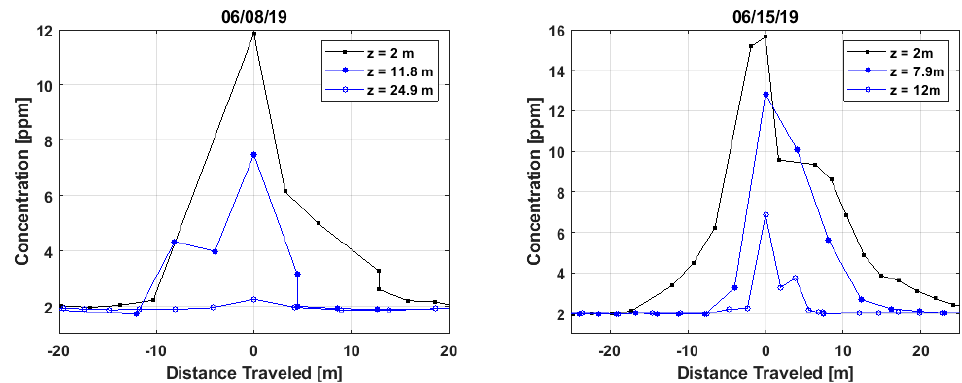
Figure 7. Examples of plume transects as the sUAS flies at different altitudes.